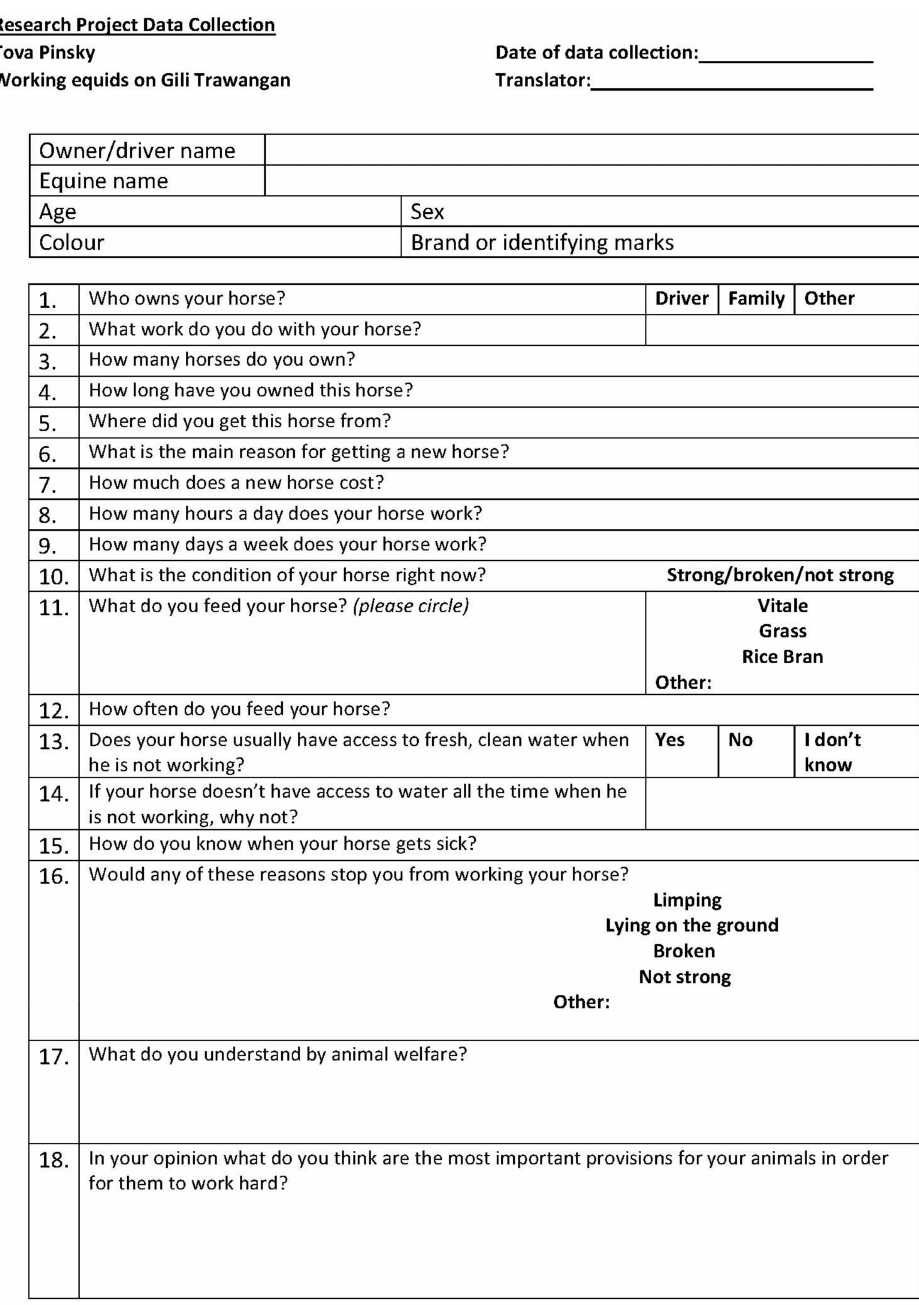
Figure A1. Cart driver questionnaire used to collect data on cart driver demographics, pony ownership, pony husbandry, and knowledge and attitudes of pony health and welfare. The cart driver questionnaire was administered through a local translator when the driver was not fluent in